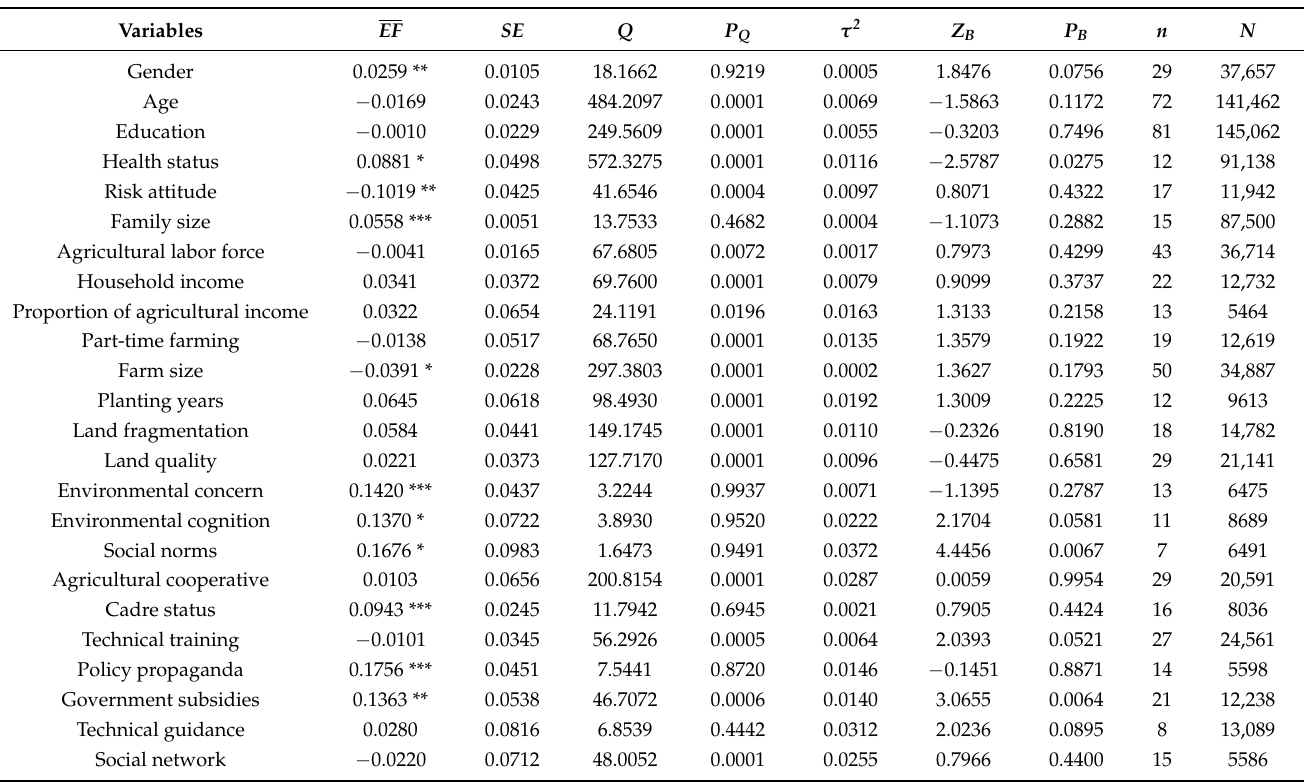
Table 2. Comprehensive effect sizes and tests.